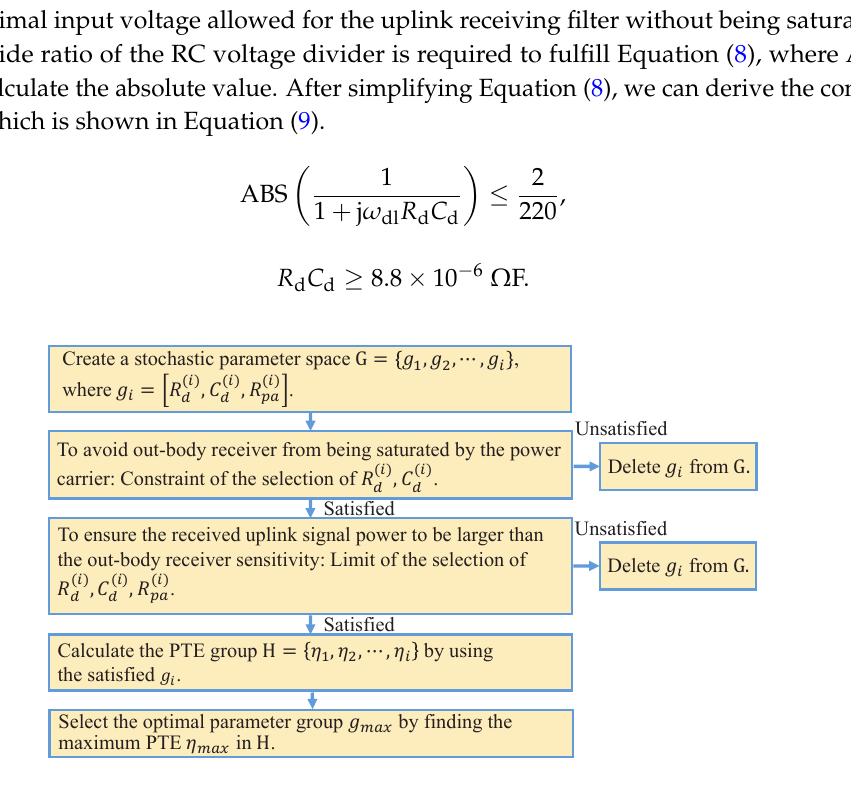
Figure 4. Optimization procedure for the inductive link circuit